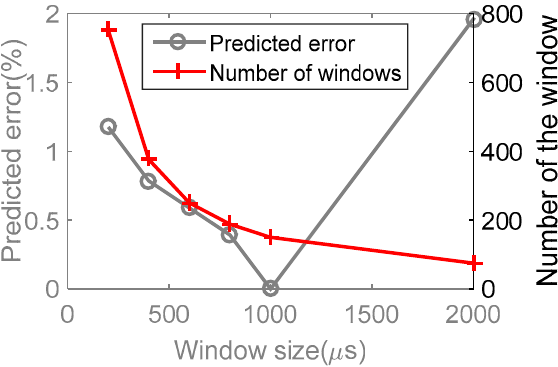
Figure 16. The relation of the predicted error and the number of the windows in relation to the window size.